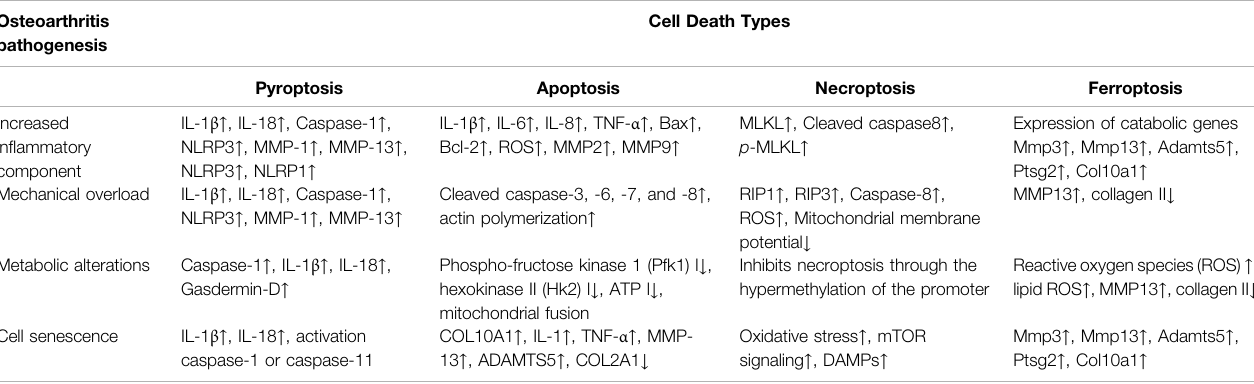
TABLE 3 | Summary of the pathogenesis of osteoarthritis (OA) and the relationship with different types of cell death (Hunter and Bierma-Zeinstra, 2019; An et al., 2020; RieggerandBrenner,2019;Shietal.,2019;Royceetal.,2019;Zhouetal.,2021;Yaoetal.,2021;Lietal.,2020;Tangetal.,2018;Xuetal.,2019;Sunetal.,2021;XuL. et al., 2020; Tian et al., 2020; Aluganti Narasimhulu and Singla, 2021; Zu et al., 2019; Zhao Y. et al., 2018). Osteoarthritis